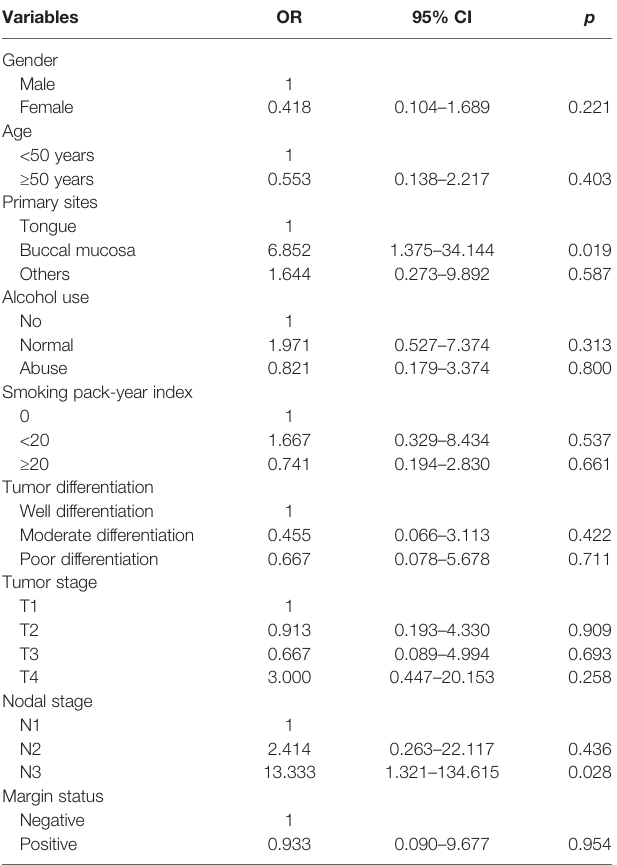
TABLE 2 | Independent predictive factors associated with level IB lymph node metastasis in patients with node-positive disease ( n = 61).